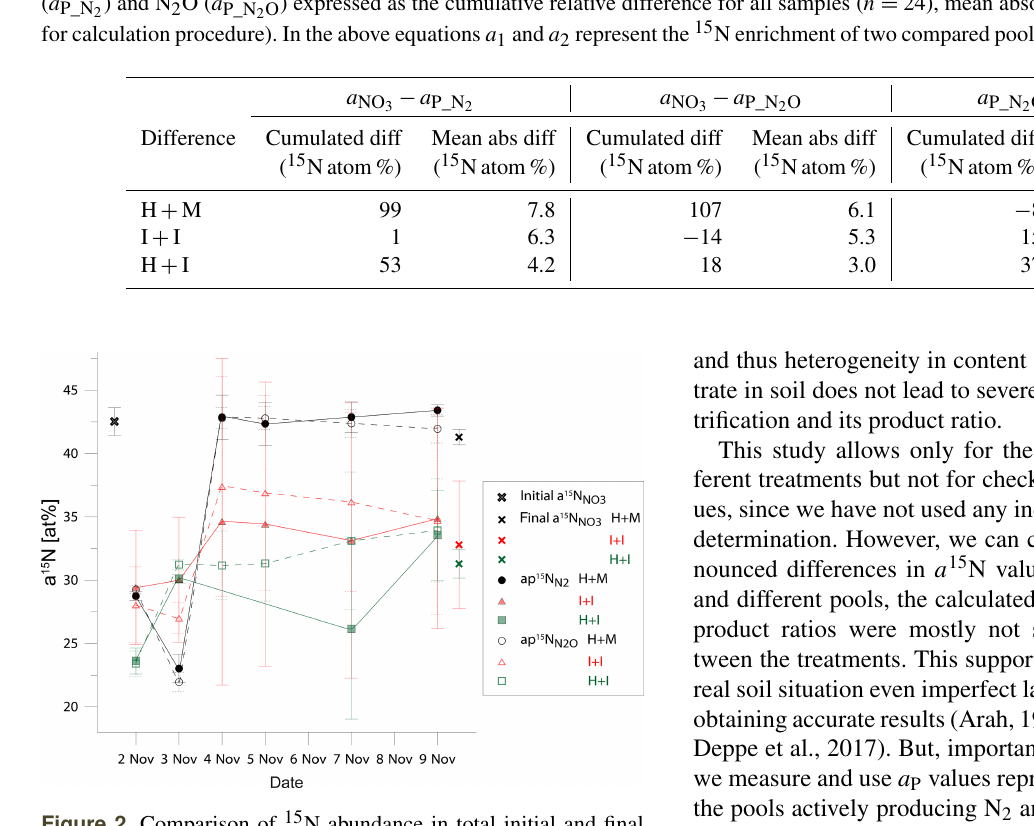
) and determined 15 N abundance of 15 N-pool-derived N 2 3